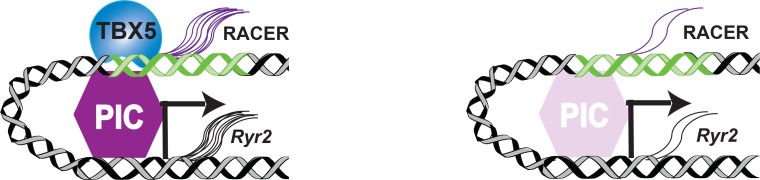
TF-dependent transcription of regulatory elements.mRNA and enhancer transcription occur in the presence of transcription factor (TBX5) through the Transcription Preinitiation Complex (PIC) (left). Loss of the TBX5 results in decreased PIC complex, leading to decreased enhancer ncRNA (RACER) and mRNA (Ryr2) transcription (right).